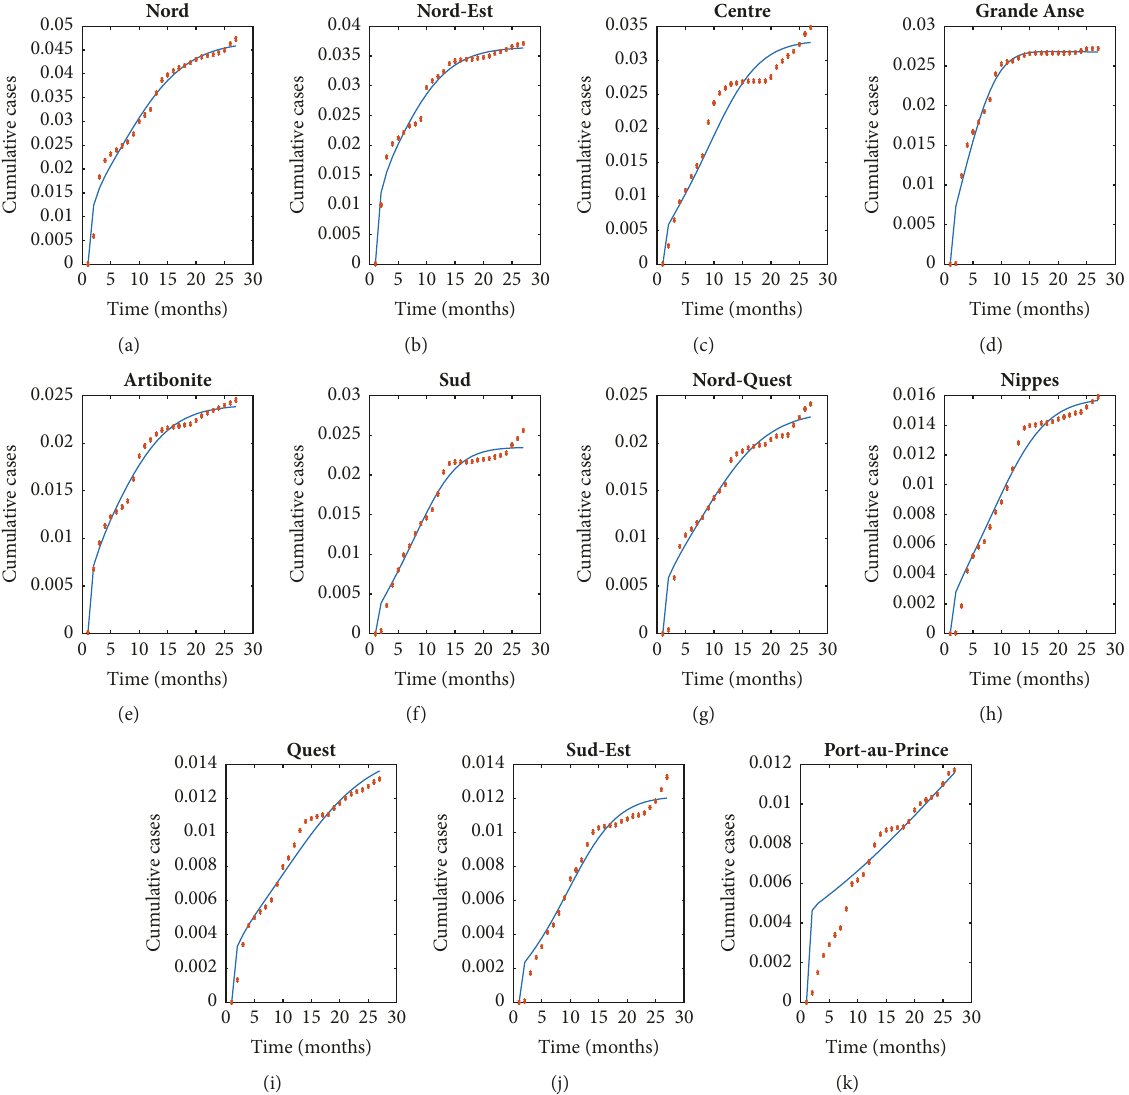
Figure 5: Model fitting of the cumulative per capita reported cholera cases for each department in Haiti from October 30, 2010 to December 24, 2012. The bold lines represent the model fit and the stars represent the reported cases in Haiti. These graphs are now ordered according to the per capita overall increases in infections as seen in Figure